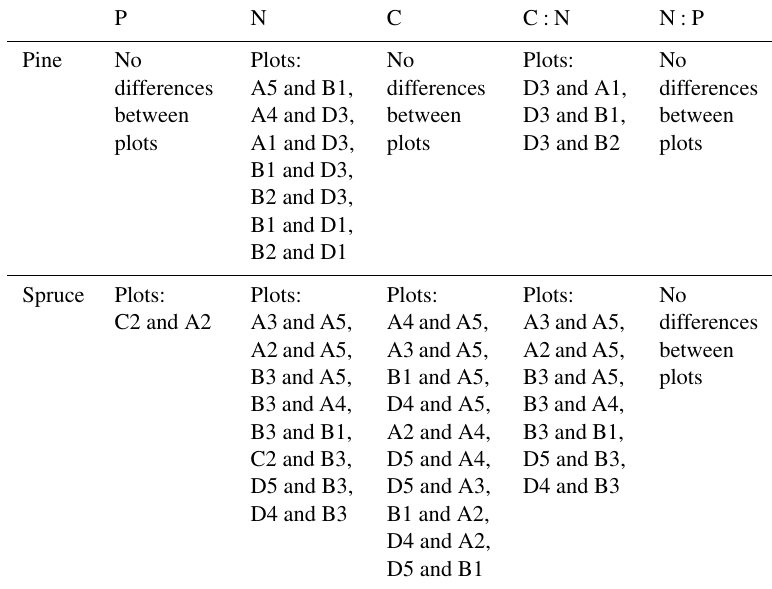
Table D2. Statistically significant differences of needle nutrient contents between plots, p< 0 .